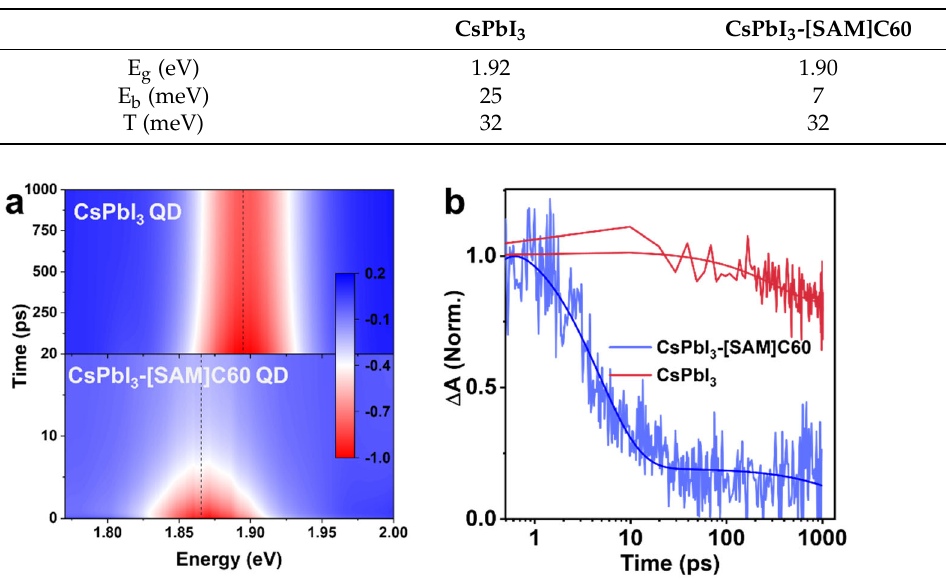
Figure 3. ( a ) The band-edge absorption of CsPbI 3 QDs and CsPbI 3 -[SAM]C60 QDs fitted with Elliott formula (Con and Exc represent continuous band and exciton absorption, respectively). ( b ) Excitation power-dependent PL spectra. Table 1. Parameters fitted from absorption spectrums with Elliott formula.